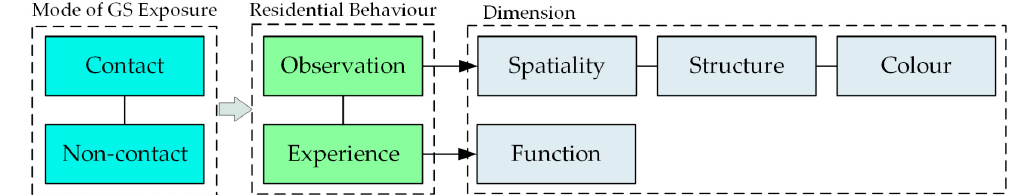
Figure 1. A conceptual framework for dimension generation.